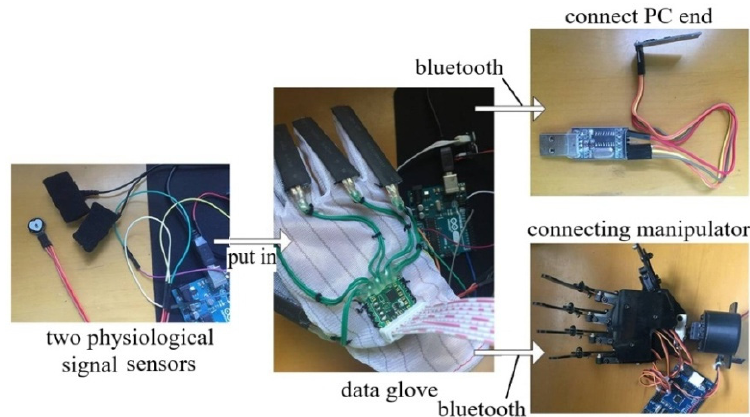
Figure 11. Connection of test equipment that virtual gesture change driven by emotion.